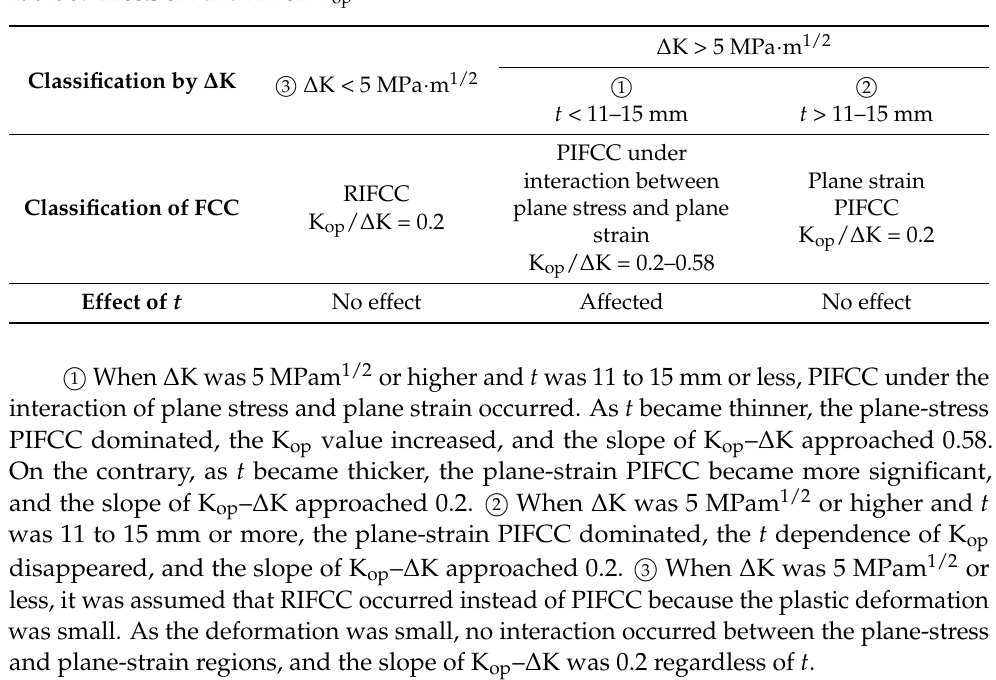
Table 3. Effects of t and ΔK on K op .